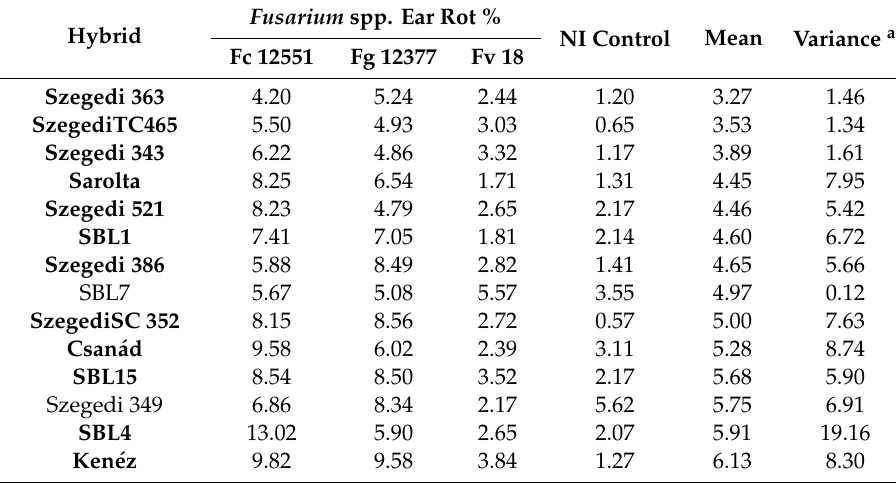
Table 1. Resistance of maize hybrids to toxigenic fungi. Toothpick method, ear severity as percentage, Szeged,